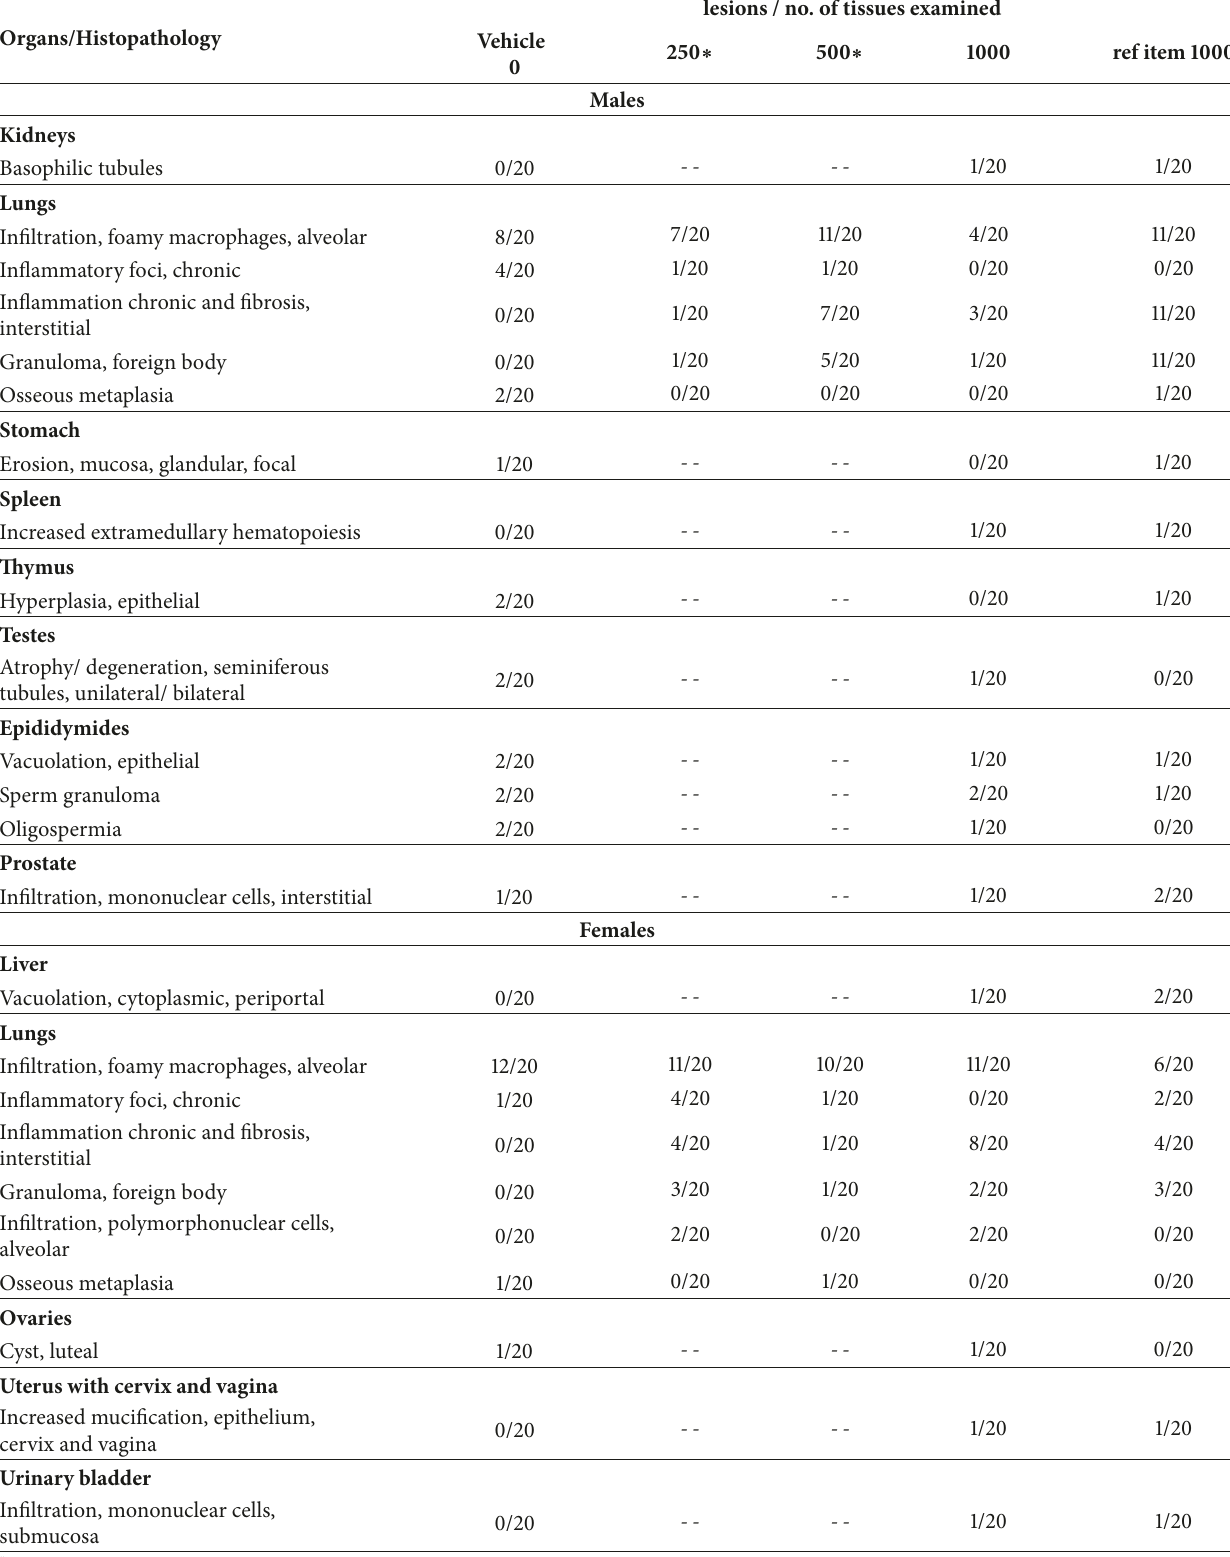
Table 16: Summary of relevant # histopathological